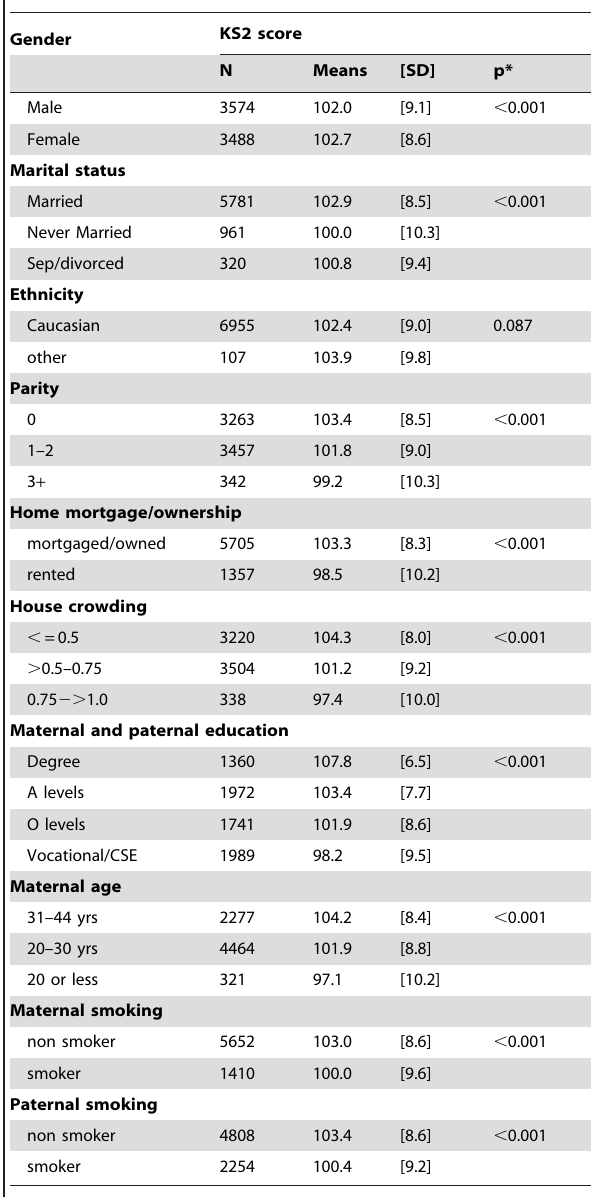
Table 2. Univariable associations between maternal and paternal patterns of alcohol consumption during pregnancy and child’s KS2 scores [means (SD)] at age 11.